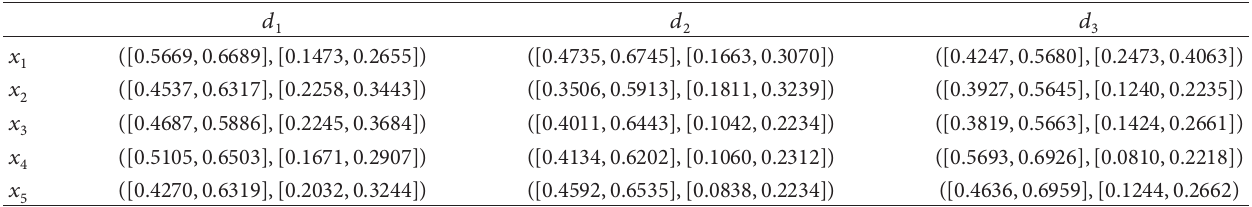
̇𝑅 obtained by utilizing P-GIIFOWG operator.